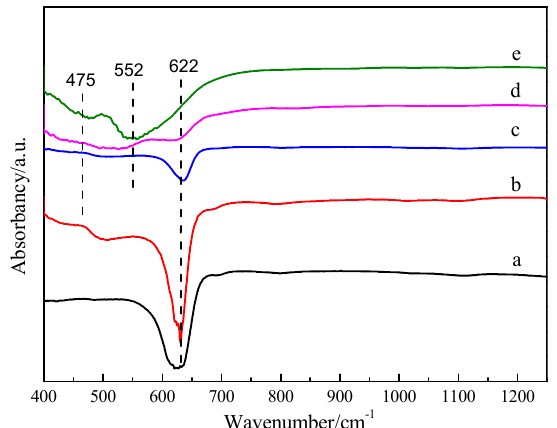
Figure 2. FT-IR spectra of Cu 2 O and Cu x O-Fe y O z with di ff erent Fe / Cu ratios ( a ) Cu 2 O, ( b ) CF-0.05, ( c ) CF-0.1, ( d ) CF-0.8, and ( e ) CF-2.